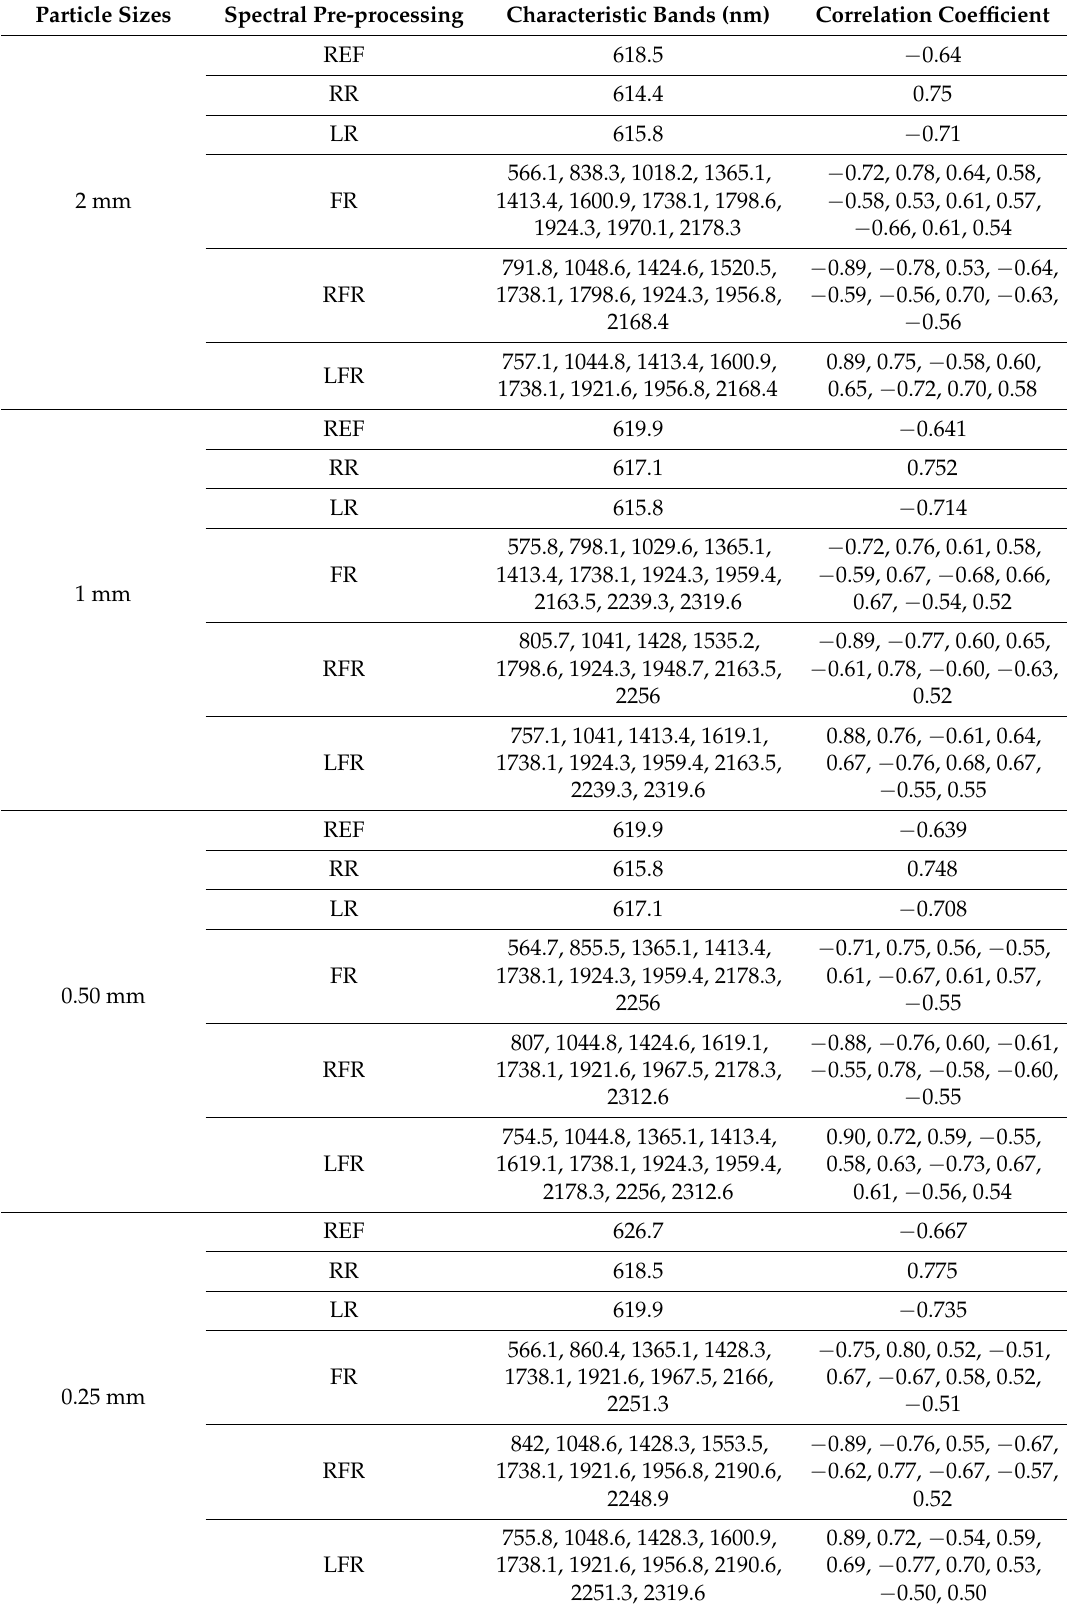
Table 2. Characteristic bands and correlation coefficients of SOM with different particle